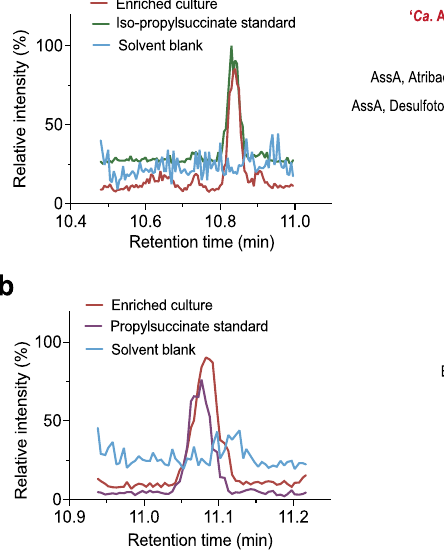
Fig. 4 | Detection of metabolic intermediate in propane oxidation and phylo- genetic af fi liation of AssA amino acid sequences in ‘ Ca . A. nitratireducens ’ genome. a Partial ion chromatograms (ion transition, m/z : 289>147.2) of the enriched culture extracts ( n =3, taken at various time points) revealed a peak at retention time 10.832min, matching the peak of the iso -propylsuccinate standard. b A peak at retention time 11.078min (ion transition, m/z :